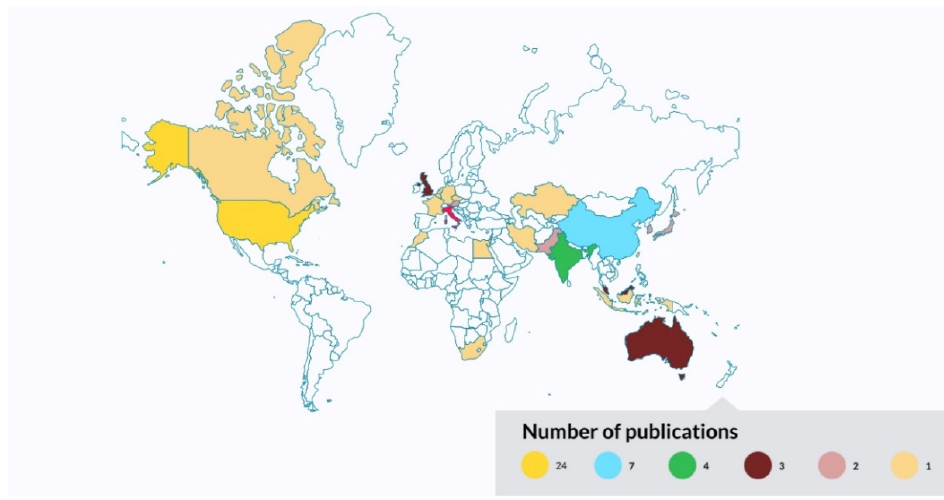
Figure 9. Geographical scientometric analysis of the included review works.